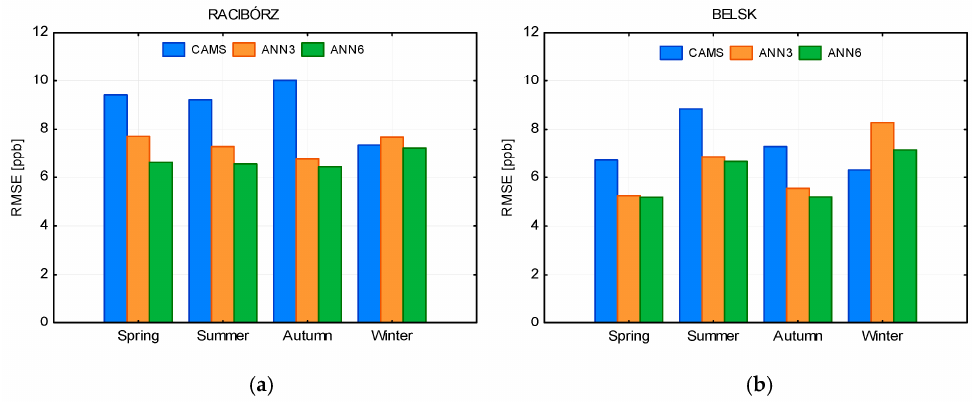
Figure 15. RMSE for the best CAMS forecast, ANN3 and ANN6 for Racibórz ( a ) and Belsk ( b ).